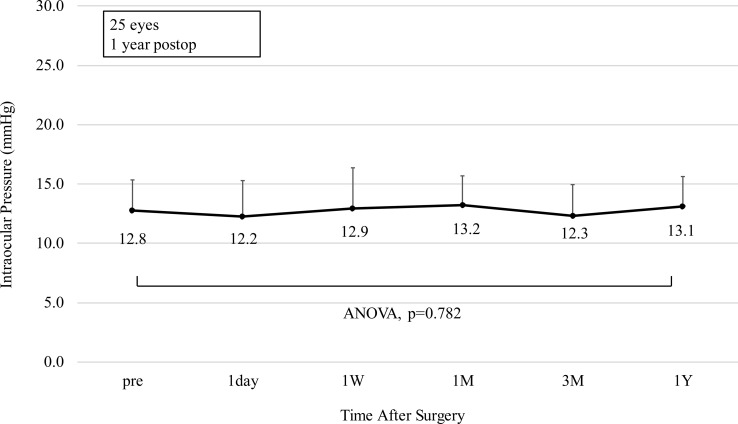
Change in intraocular pressure after implantation of an implantable collamer lens with a central hole.The points depict mean values and the error bars depict the upper bound of the standard deviation. ANOVA = analysis of variance, W = week, M = month(s), Y = year.